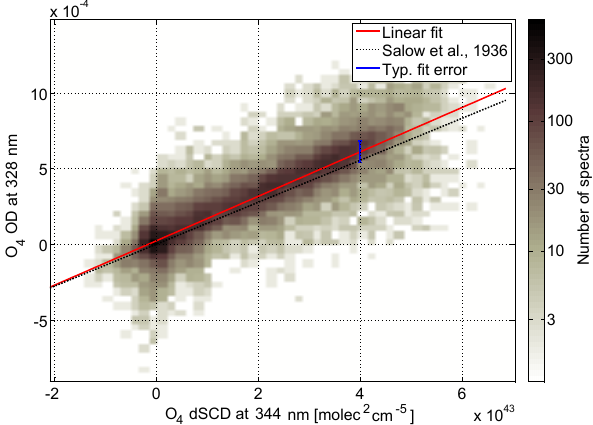
Figure 5. Correlation of O 4 dSCD at 344nm and the fitted O 4 OD at 328.5nm assuming the same shape of the absorption cross sec- tion as at 344nm, using the PPAO MAX-DOAS data set. The wave- length dependence of the O 4 AMF was not corrected